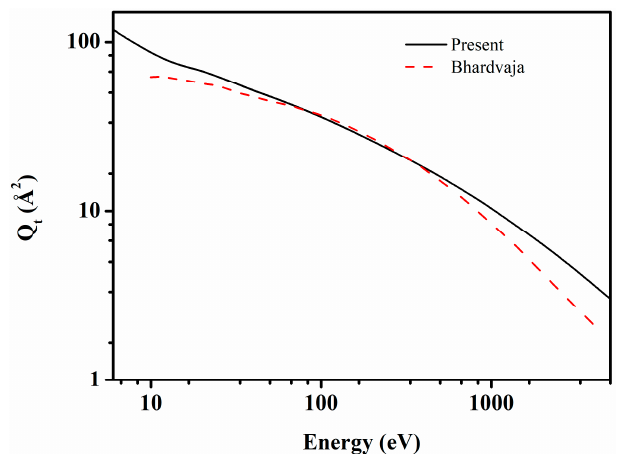
Figure 6. Total cross-section of butanol isomers (present): solid (black) line represents butan-1-ol, dashed (olive) line is for butan-2-ol, dash-dot (red) line is for 2-methylpropan-1-ol and dash-dot-dot (blue) line represents 2-methylpropan-2-ol.